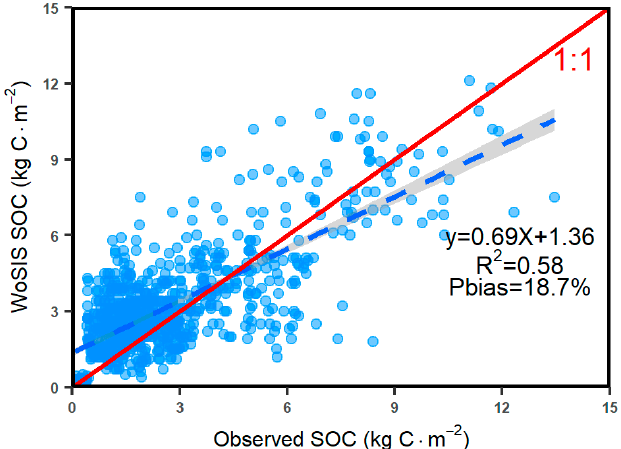
Figure 2. Comparison of gridded World Soil Information Service (WoSIS) soil organic carbon (SOC) dataset and in situ observations.